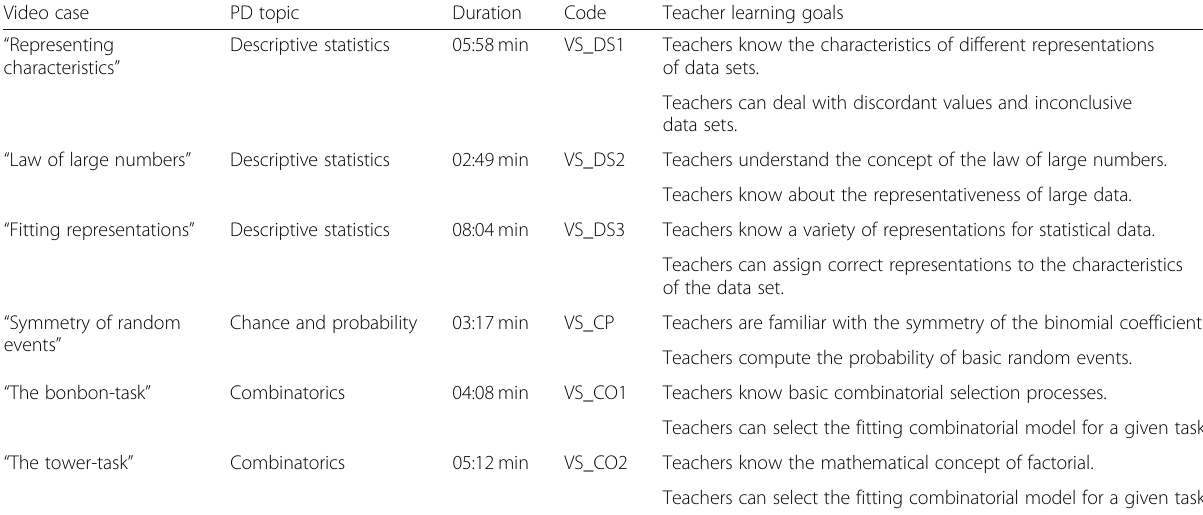
Table 3 Overview of the selected video